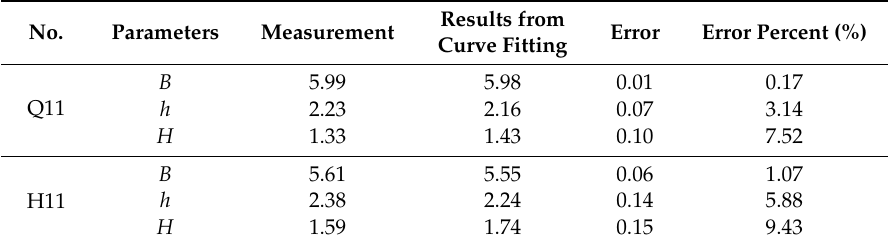
Table 8. Verification results (\mm).